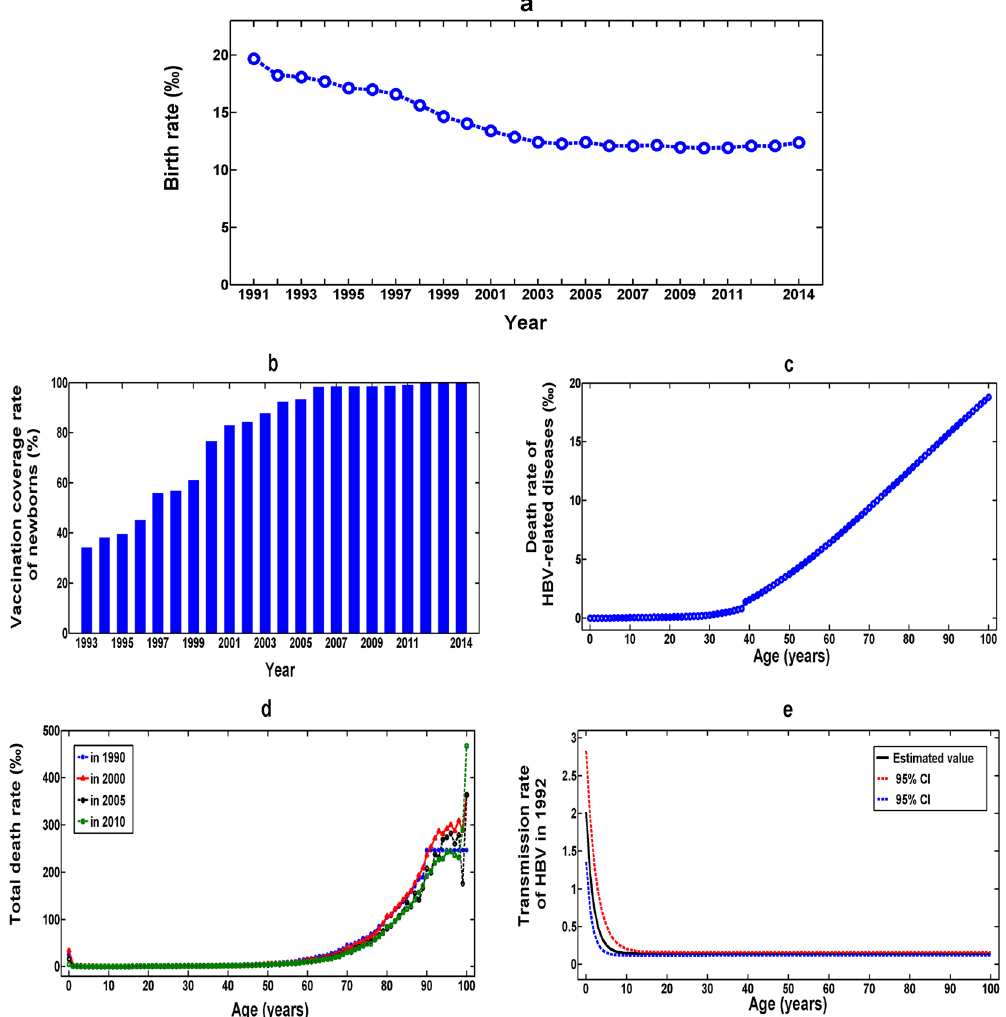
Figure 2. Model input parameters. ( a ) Birth rate from 1991 to 2014. ( b ) Vaccination coverage rate of newborns from 1993 to 2014. ( c ) Age-specific mortality rate of HBV-related diseases. ( d ) The age-specific total death rate in 1990, 2000, 2005 and 2010. ( e ) The age-specific transmission rate of HBV in 1992 and its 95% confidence